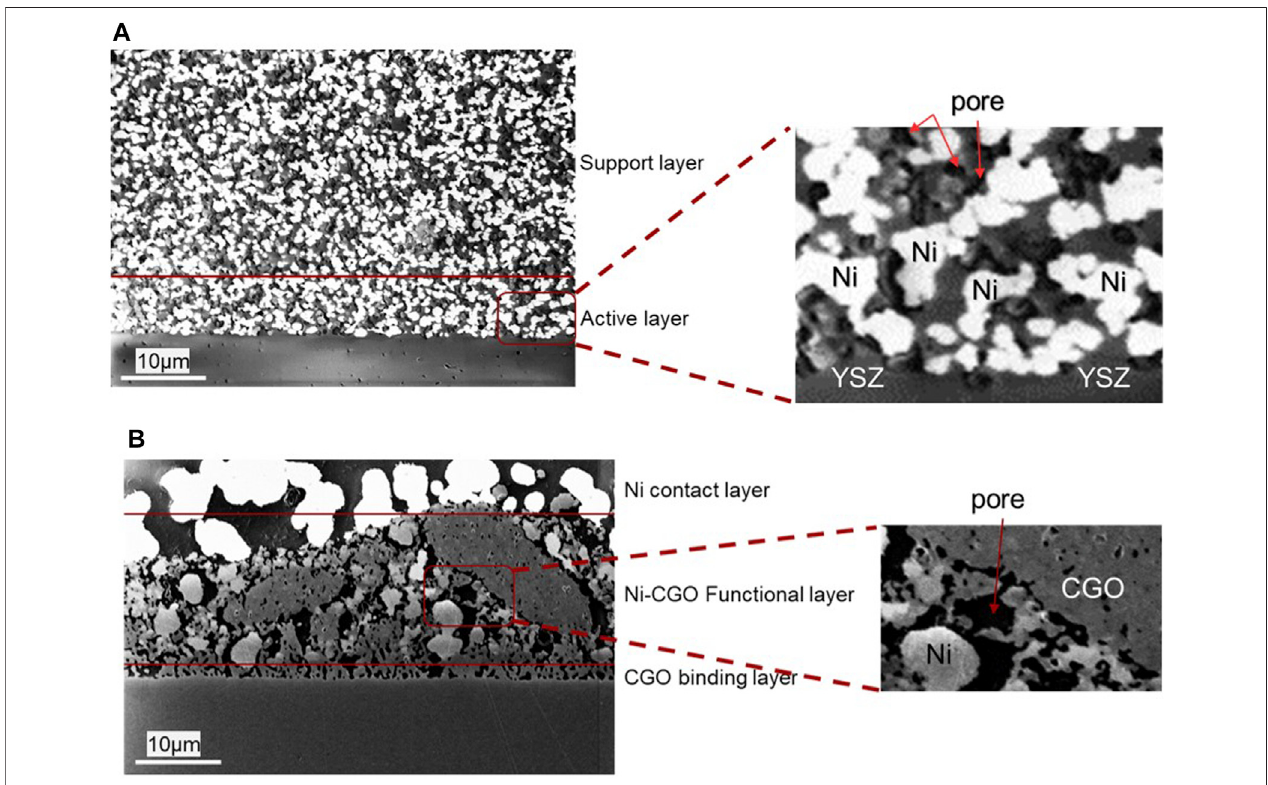
FIGURE 2 | Fuel electrode microstructure recorded at 1 keV using an in-lens detector in SEM for (A) ASC composed of pores (black), percolating Ni (bright) and YSZ (grey) distributed uniformly and (B) ESC with the CGO binding layer close to the electrolyte, the active layer composed of Ni (bright), CGO (grey) and pores (black), and as the top layer a Ni contact layer consisting of larger percolating Ni